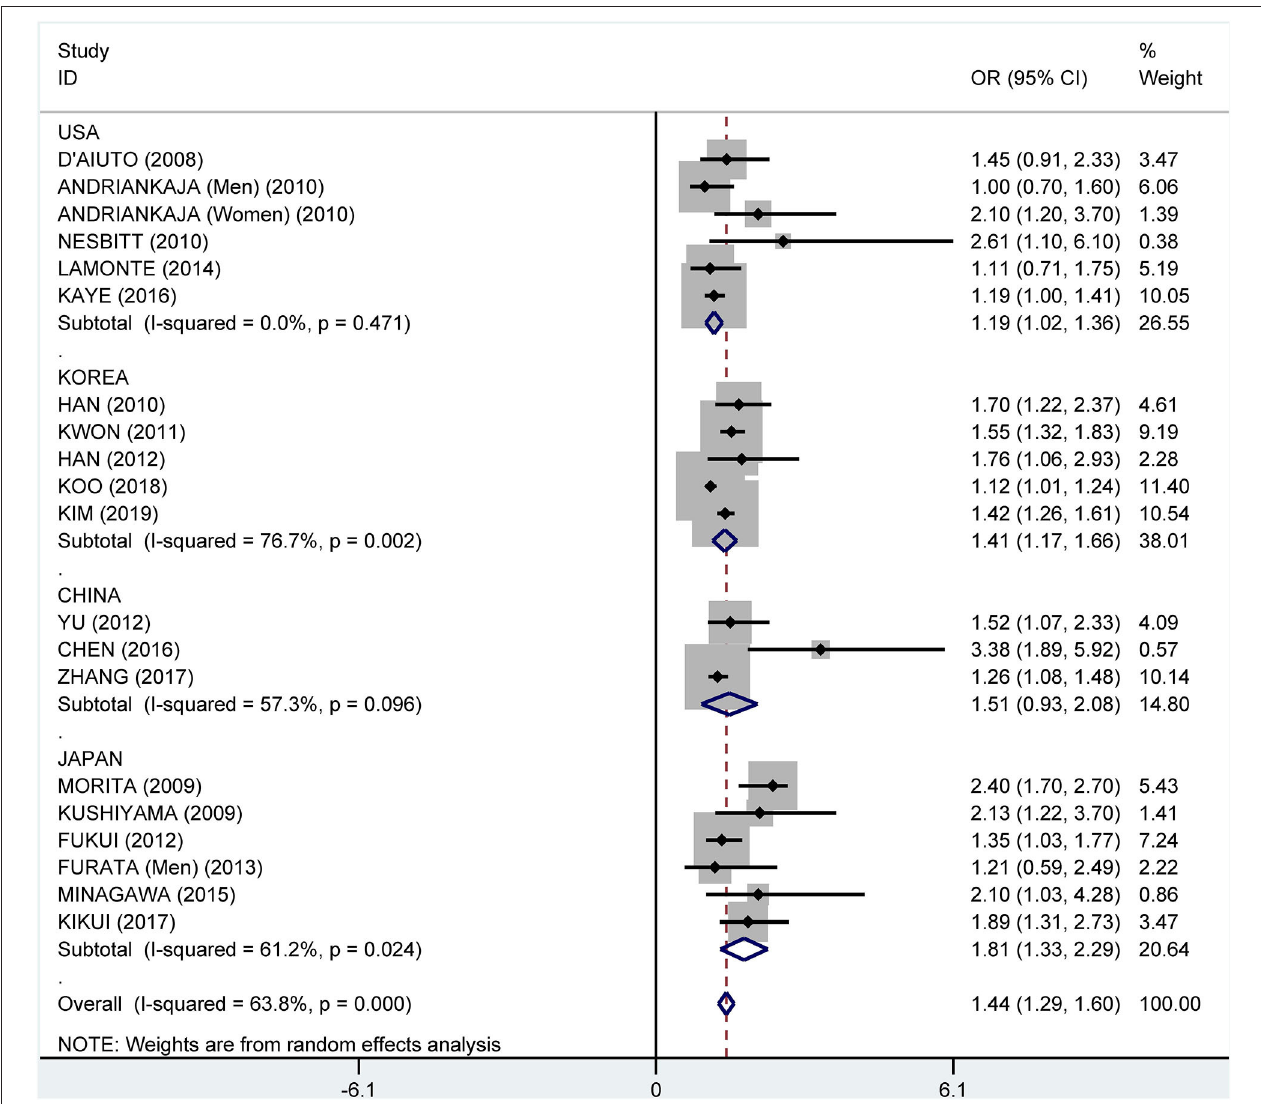
FIGURE 10 | Subgroup analysis of pooled adjusted odds ratios of the association between periodontitis and metabolic syndrome by